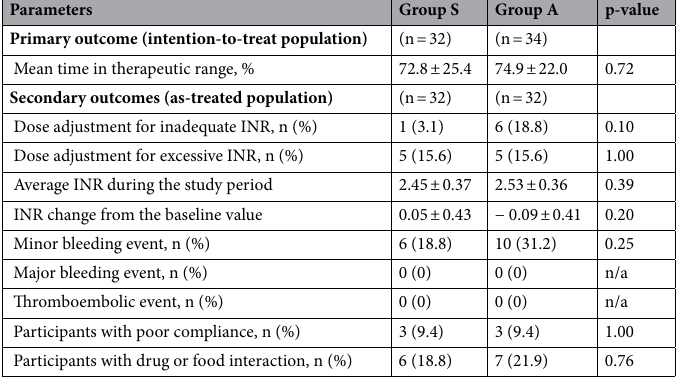
Table 3. Study outcomes in the intention-to-treat and as-treated population. Plus-minus values are means ± standard deviation. IQR interquartile range.